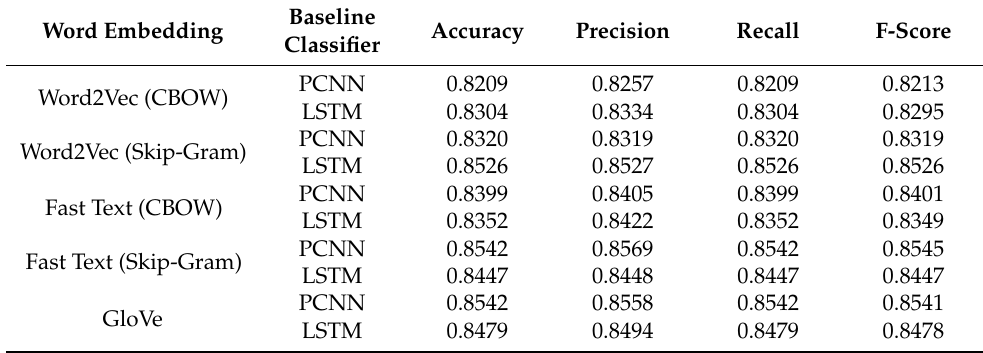
Table 8 . The performance of baseline models with different embeddings . Table 8. The performance of baseline models with different embeddings.